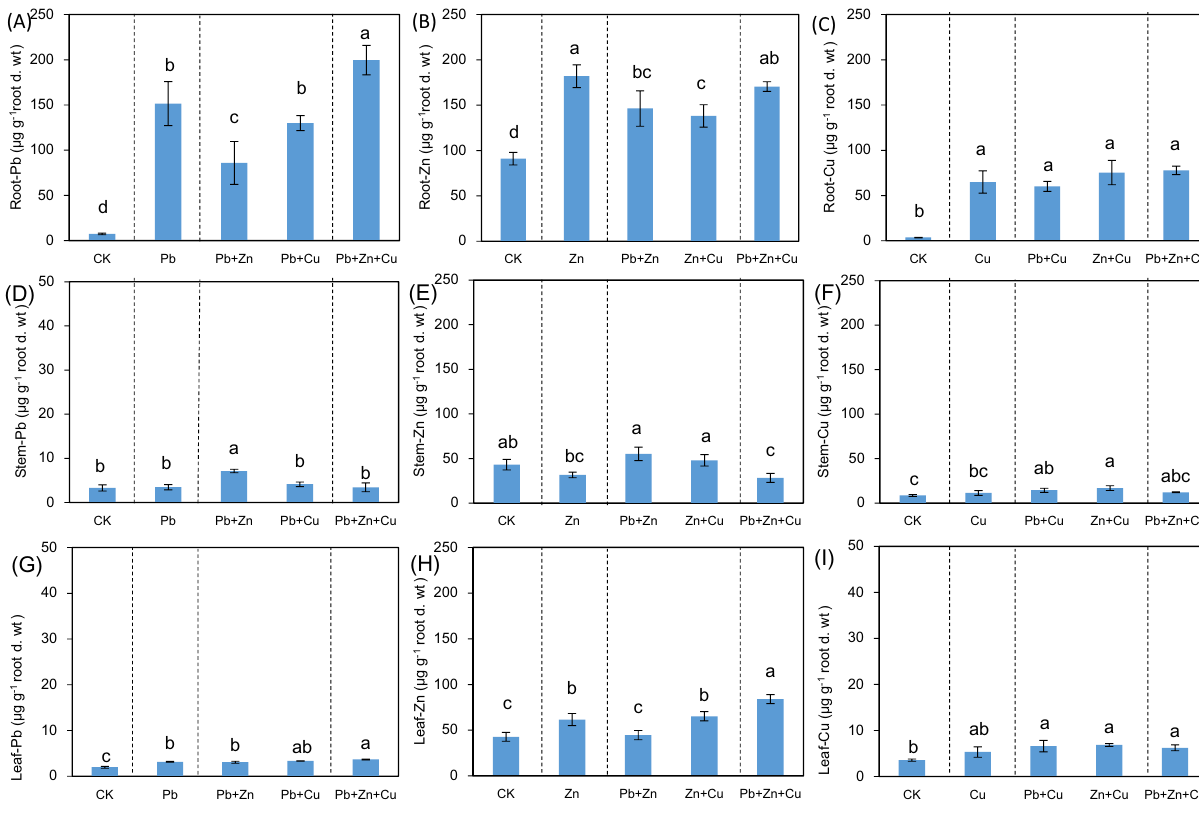
Figure 3. Heavy metals accumulation in roots, stems, and leaves of Kandelia obovata under individual and different combined stress of Pb, Zn, and Cu (μg g −1 root d. wt). Different lowercase letters indicate significant differences among treatments ( P < 0.05).